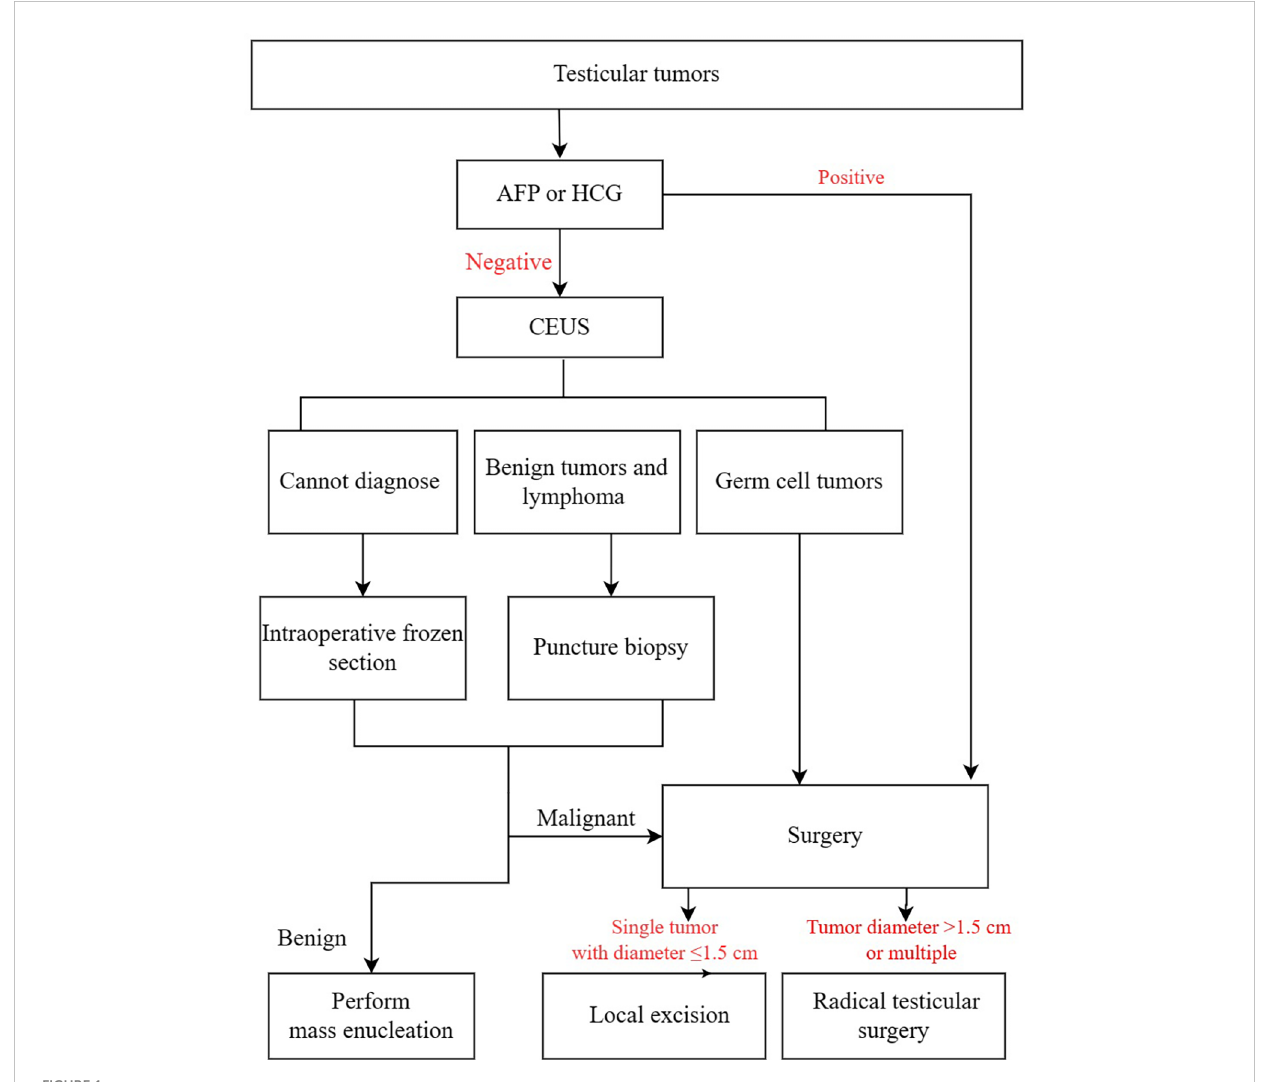
FIGURE 1 Clinical fl ow